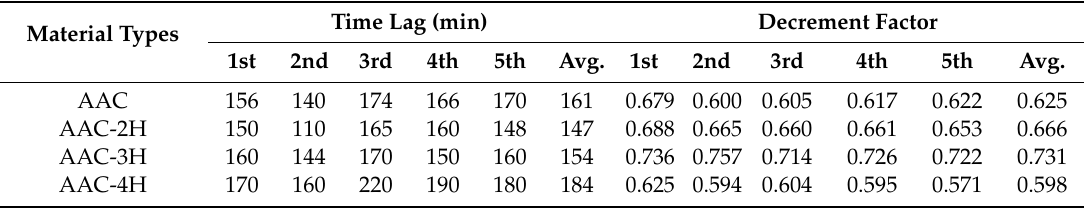
Table 5. Time lag and decrement factor of the 4 testing